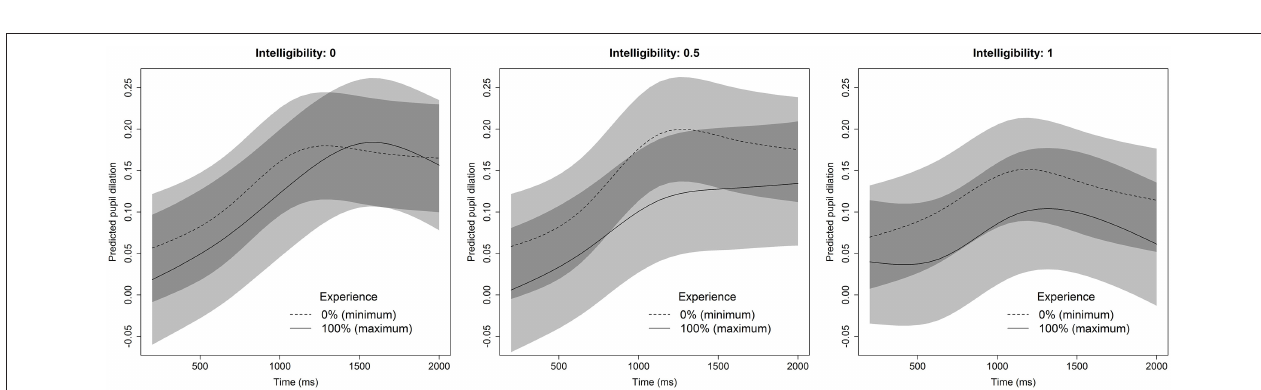
FIGURE 3 | Time-course plots of pupil dilation values predicted by the model at three values of intelligibility (0, 0.5, and 1), each comparing minimum experience and maximum experience. Shaded bands indicate 95% confidence intervals.